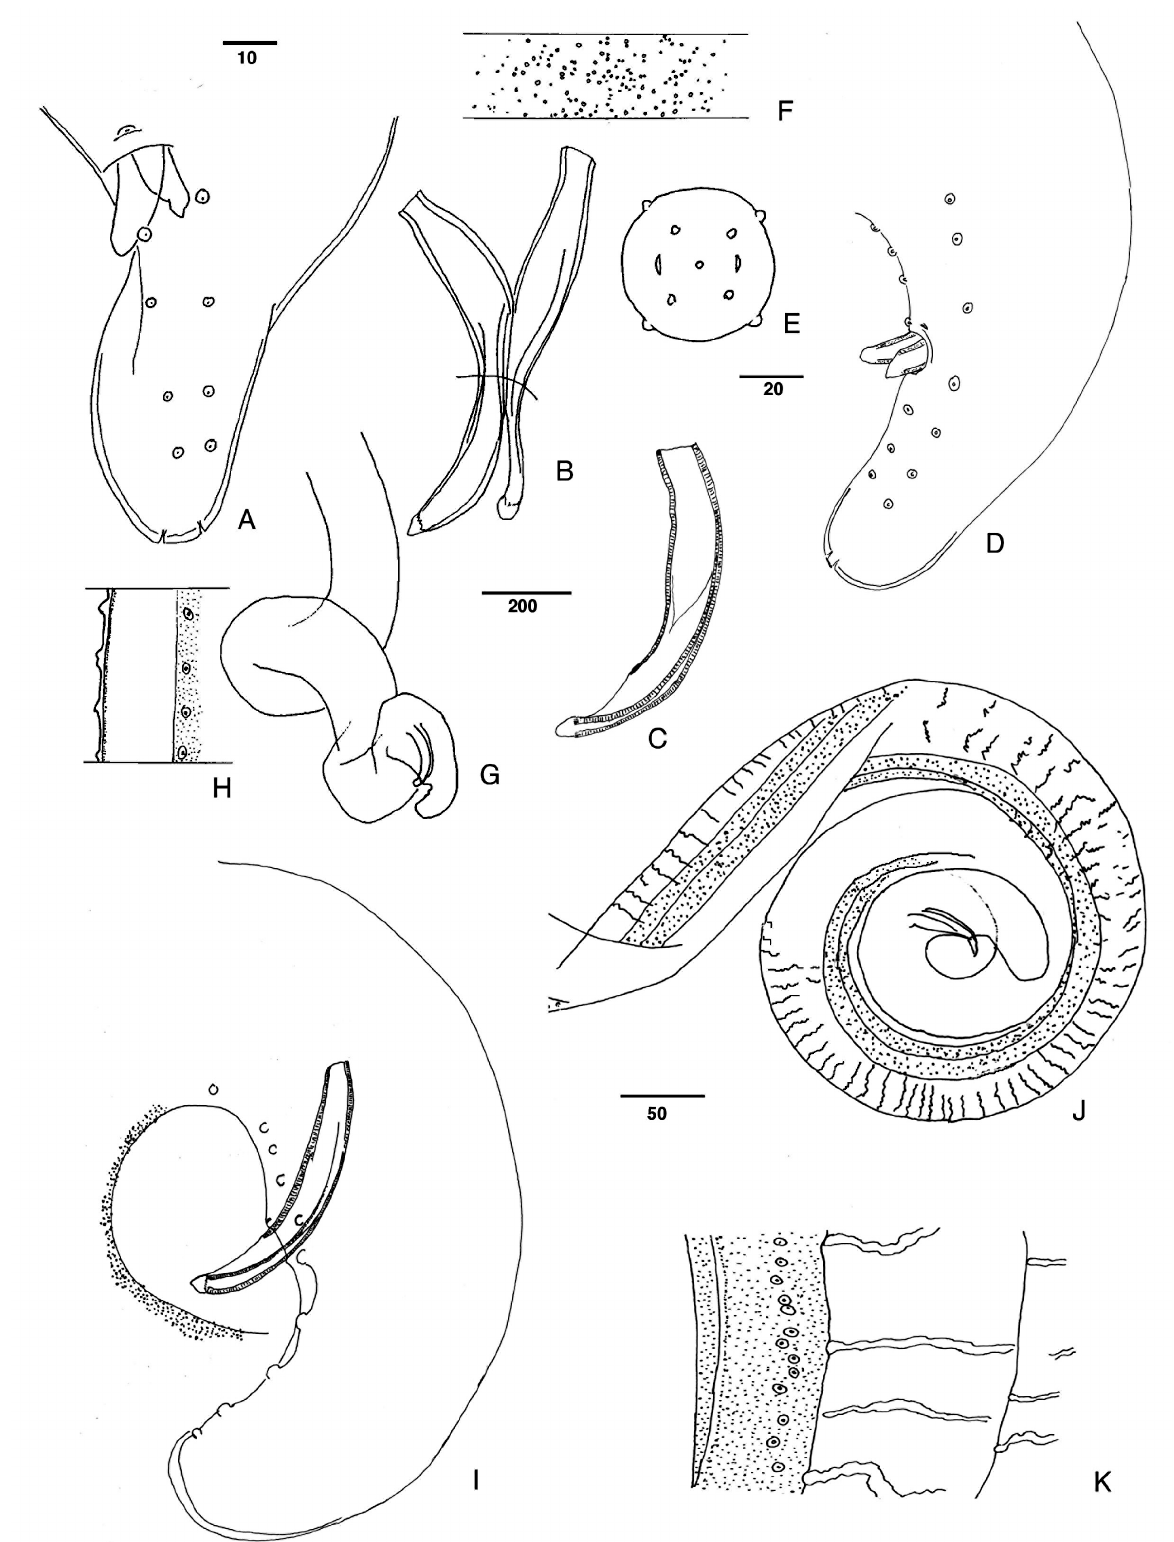
ventral view. G. Coiled posterior extremity. H. Cuticular crests (groves), longitudinal lateral view. I-K. From Alces alces, paratypes. I. Caudal region showing papillae, area rugosa and right spicule, left lateral view. J. Coiled posterior region with transverse crests, mainly dorsal. K. A subdorsal quadrant with transverse crests, and half a lateral chord. Scales in µm: A: 10; B, D, I, K: 50; E: 20; G, J: